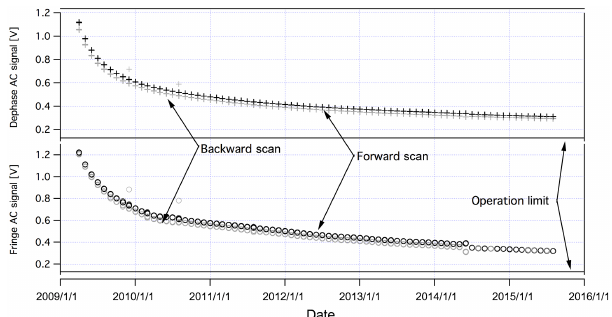
Figure 3. Detected laser signal amplitude of dephase and fringe and the minimum level of 0.13V (solid level) to control the FTS